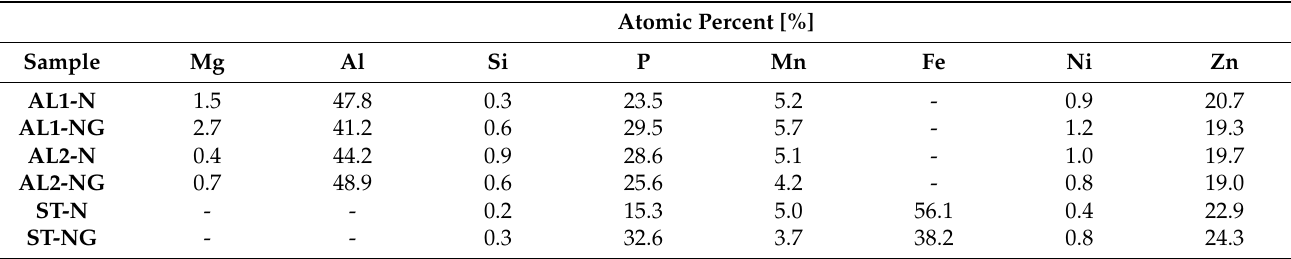
Table 4. The relative chemical composition of zinc phosphate crystals determined by the EDX analysis of the cross-section of samples as the average of the red and blue points in Figure 6. (The data are presented without the 38–58% oxygen content due to the uncertainty of its